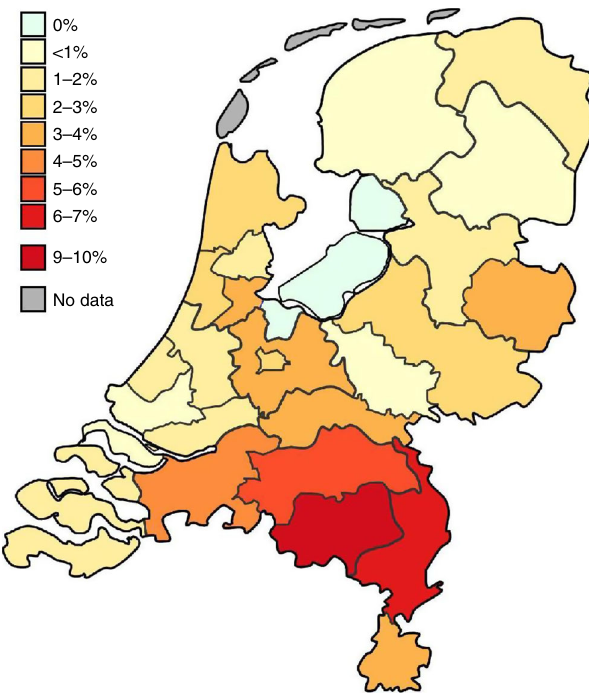
Fig. 2 SARS-CoV-2 seroprevalence in the Dutch blood donor population by municipal health service region; 1 – 15 April 2020. The map shows the Netherlands divided into municipal health service regions. The backbone of the map was provided by the Dutch Institute for Public Health and the Environment.